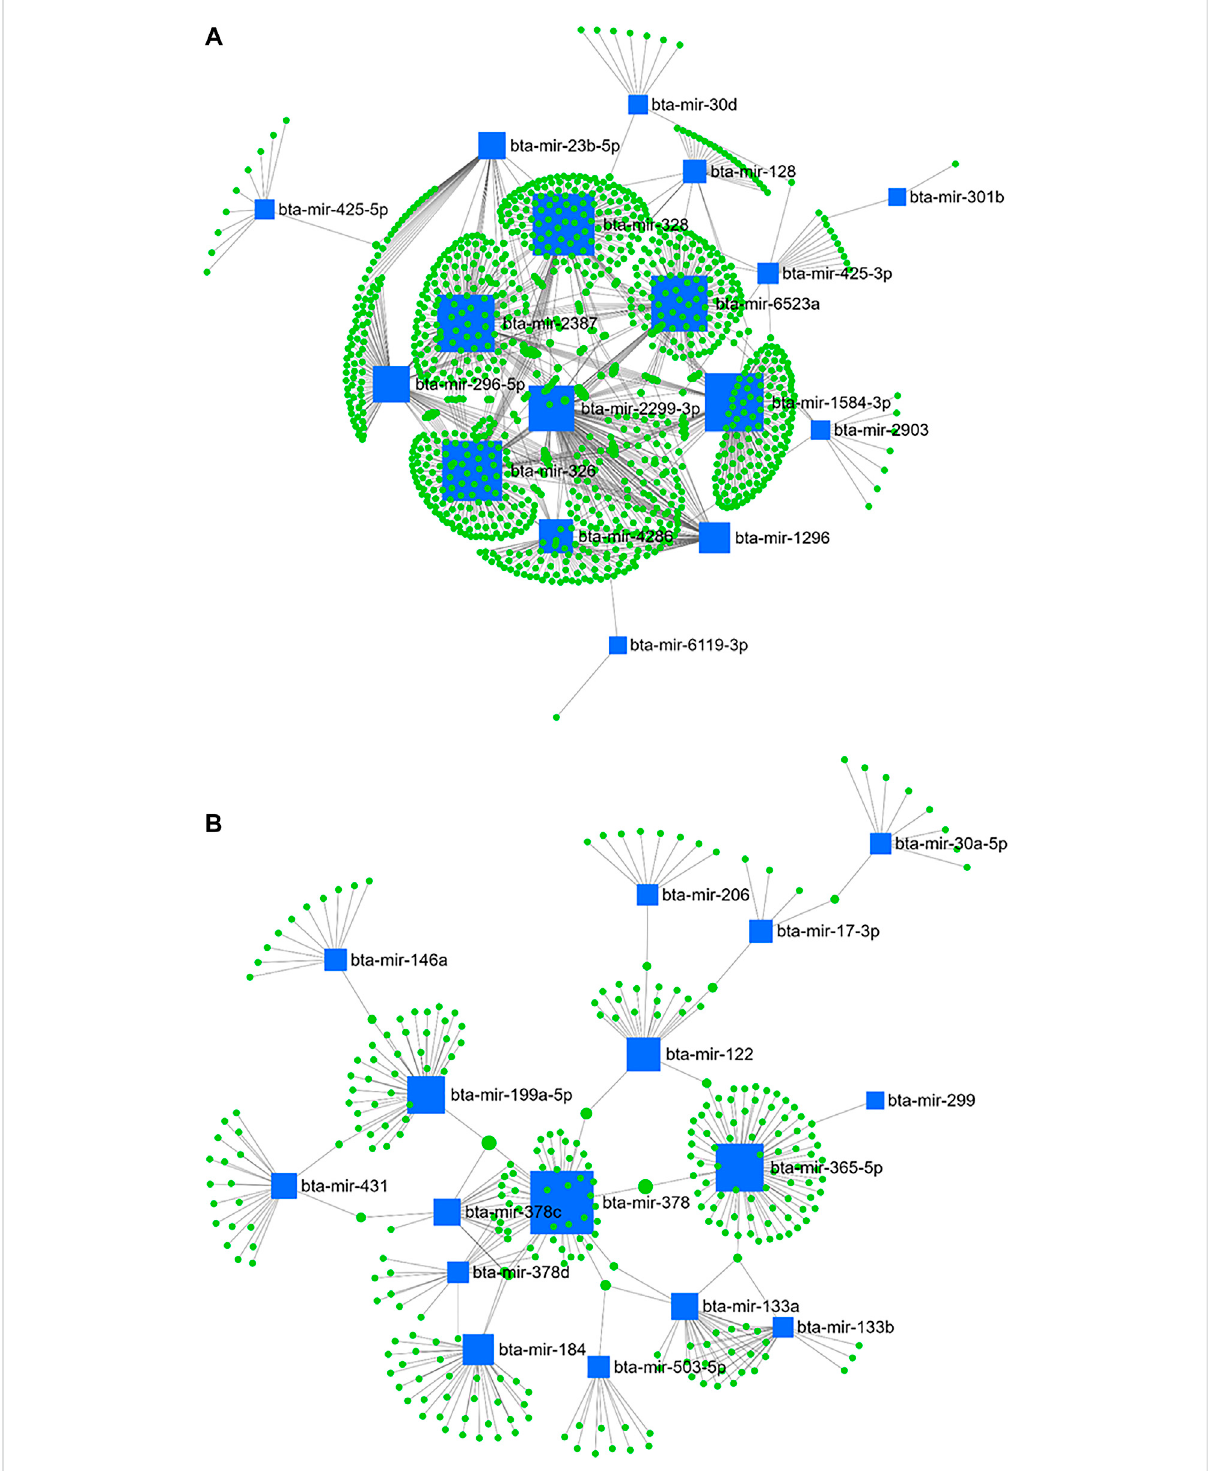
FIGURE 11 miRNA/mRNA network analysis. The regulation network of downregulated (A) and upregulated (B) miRNAs and predicted target mRNAs in d+63/+28 is illustrated by Cytoscape software. The nodes represent the mRNA (green), and the boxes represent the miRNA (blue). The box size corresponds to the centrality and betweenness of miRNA in constructing the